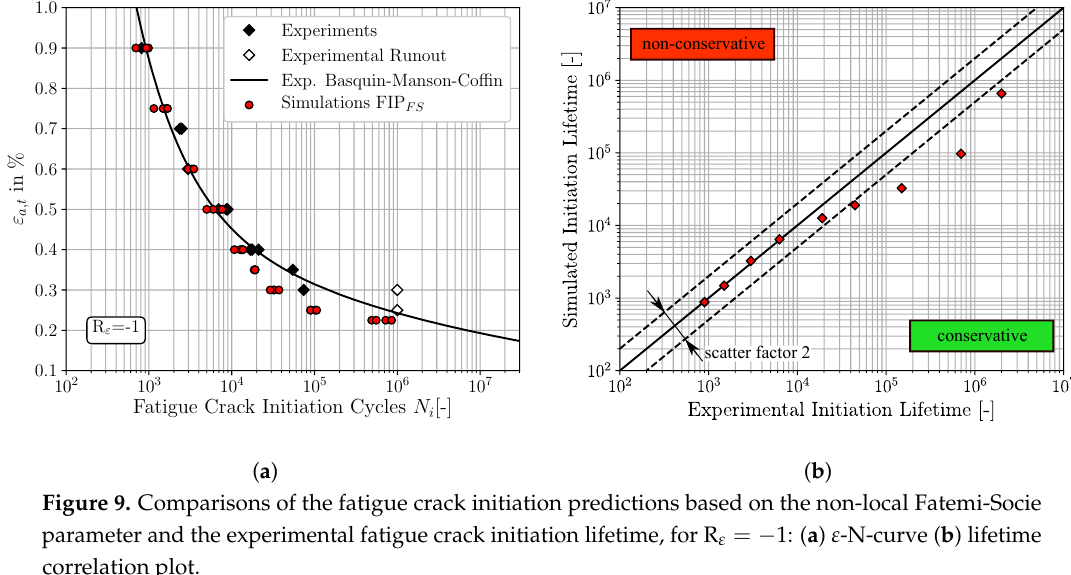
Figure 8. Comparisons of the fatigue crack initiation predictions based on the non-local accumulated plastic slip and the experimental fatigue crack initiation lifetime, for R ε = correlation plot.